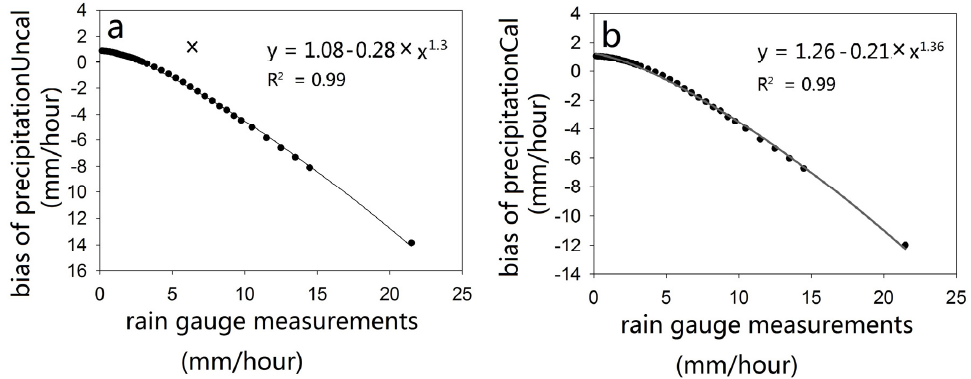
Figure 6. The scatter plots between the rain gauge measurements and the bias (bias) of hit bias contained in ( a ) un-calibrated IMERG (termed as precipitationUncal) and ( b ) calibrated IMERG (termed as